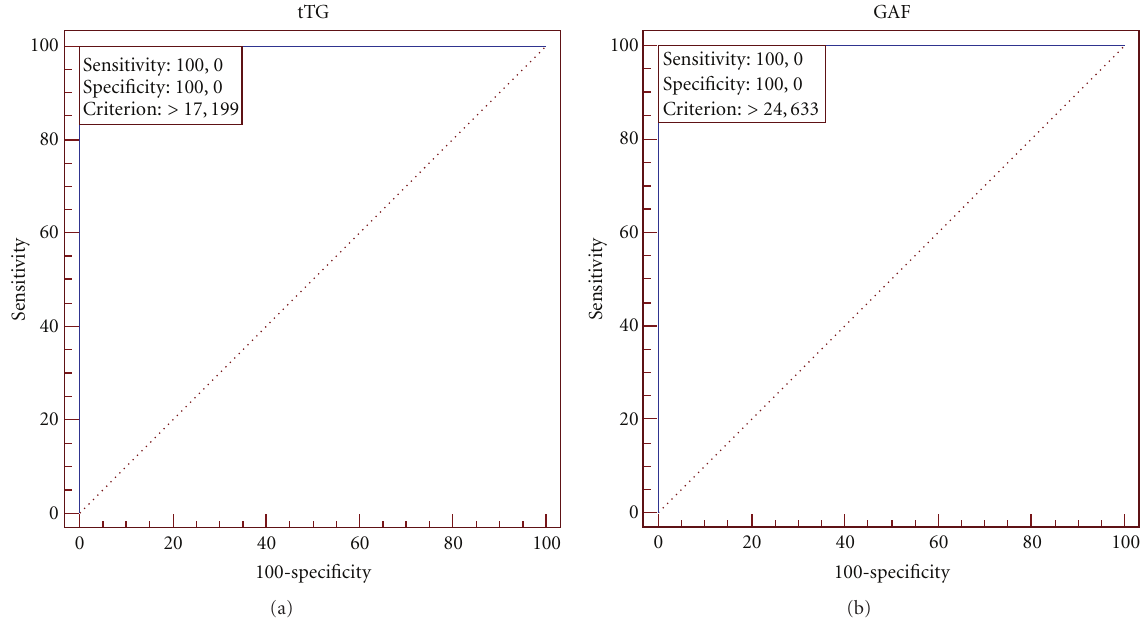
Figure 3: ROC analysis for all examined groups. (a) shows the plot for Anti-tTG IgA ELISA, and (b) shows Antigliadin (GAF-3X) IgA ELISA.The cuto ff point marked as criterion (17.199 and 24.633, resp.).